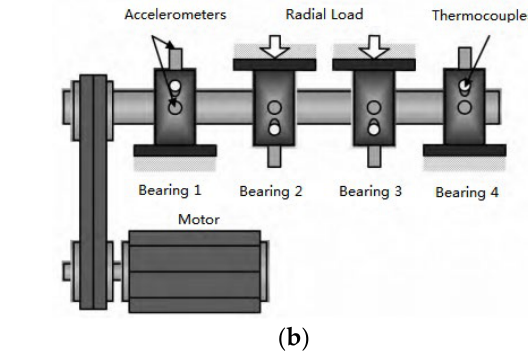
Figure 5. The experimental equipment of the state degradation of rolling bearings; ( a ) bearing test rig illustration; ( b ) sensor placement in the test rig [34].